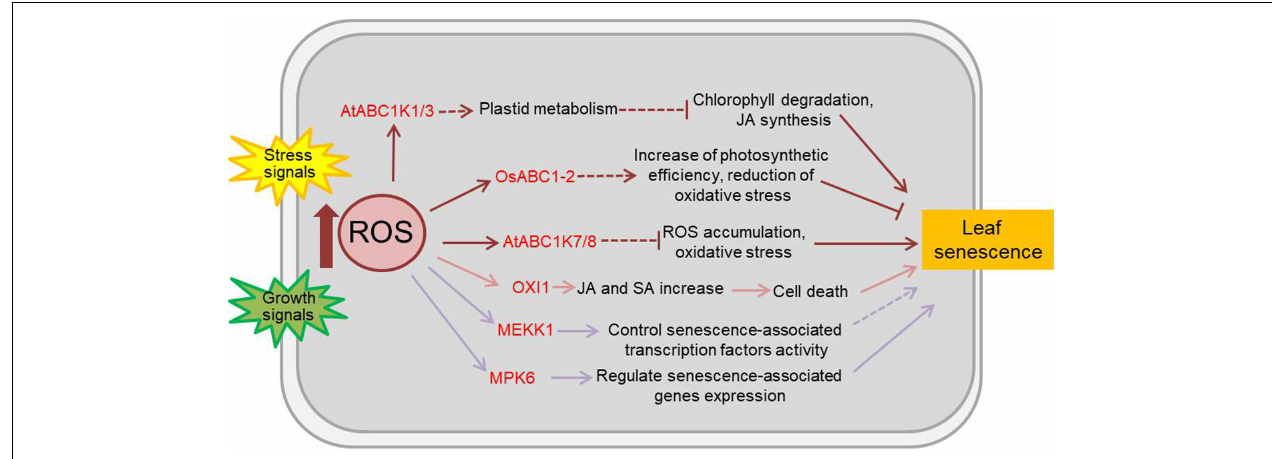
FIGURE 2 | Effects of ROS on plant leaf senescence. Numerous abiotic and biotic stresses like salinity, heat, cold, nutrients, heavy metals, insects, pathogens, etc., resulting to the accumulation of ROS and the change of kinase activity. As the main and important second messenger in plants, ROS participate in a number of physiological responses and development process including leaf senescence. The kinases functioned in ROS-regulated leaf senescence are marked in red. Arrows show that the process is promoted, and T-bars mean the process is inhibited; solid lines indicate the direct reported relationship, and dotted lines indicate indirect reported relationship. OXI1, oxidative signal-inducible 1; ABC1 atypical kinase, activity of bc1 complex kinase; MEKK1, MAPK/ERK kinase kinase 1; MPK6, mitogen-activated protein kinase 6; JA, jasmonic acid; SA, salicylic